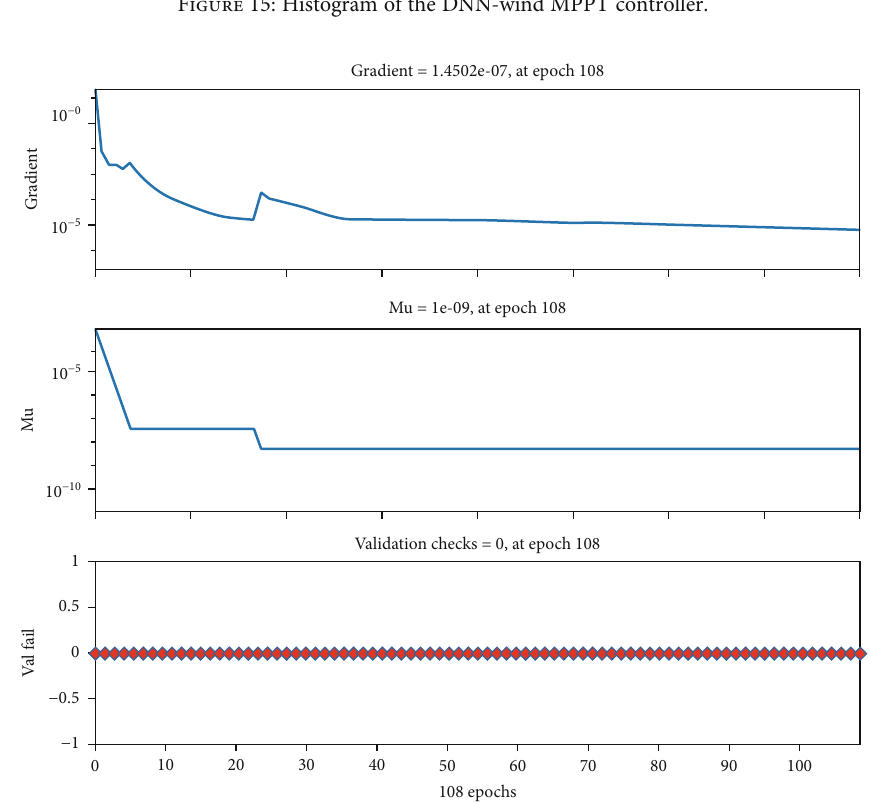
Figure 16: Training data of the DNN-wind MPPT controller.